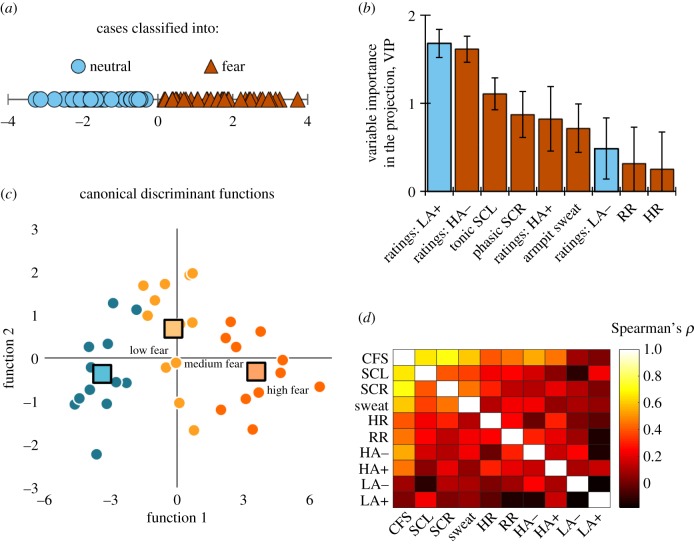
Multivariate classification of fear responses. (a) 100% correct classification of donors into fear and neutral. (b) Explanatory variables contributing most to the model based on ‘variable importance for the projection’ (VIP) scores (95% confidence intervals). Brown bars: higher values mean a greater likelihood of fear response (versus blue: neutral). (c) Classification of fear-induced donors into fear intensity categories. (d) Heat map of correlations between composite fear score (CFS) and physiological and subjective measures. SCL, skin conductance level; SCR, skin conductance response; HR, heart rate; RR, respiratory rate; HA−, high arousal–negative valence questions; HA+, high arousal–positive valence questions; LA−, low arousal–negative valence questions; LA+, high arousal–positive valence questions.